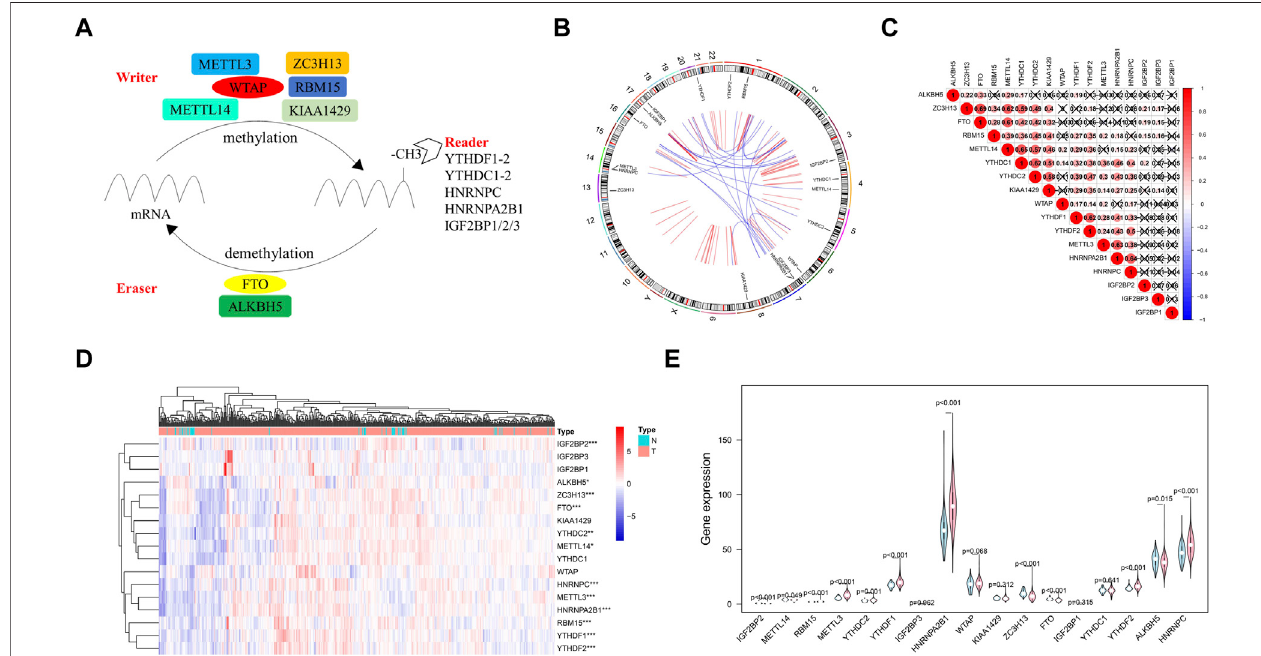
FIGURE2| Atlasofm 6 Aregulatorsinprostatecancer(PCa). (A) Theprocessofm 6 Amodi fi cationregulatedbydifferenttypesofm 6 Aregualtors. (B) Thelocationof m 6 Aregulators withinchromosomes isillustrated usingCircosplots. (C) The potential correlationamong m 6 Aregulators. (D) The expression ofm 6 AregulatorsinPCa is shown using a heat map. Red and green represent upregulated genes and downregulated genes, respectively. (E) The violin plot of the differentially expression m 6 A regulators between normal samples (light blue) and tumor samples (light